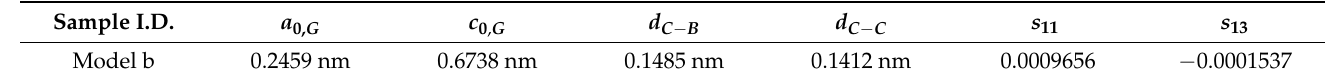
Table 4. The a 0, G , c 0, G , d C − B , d C − C , s 11 and s 13 values obtained from model (b). Sample